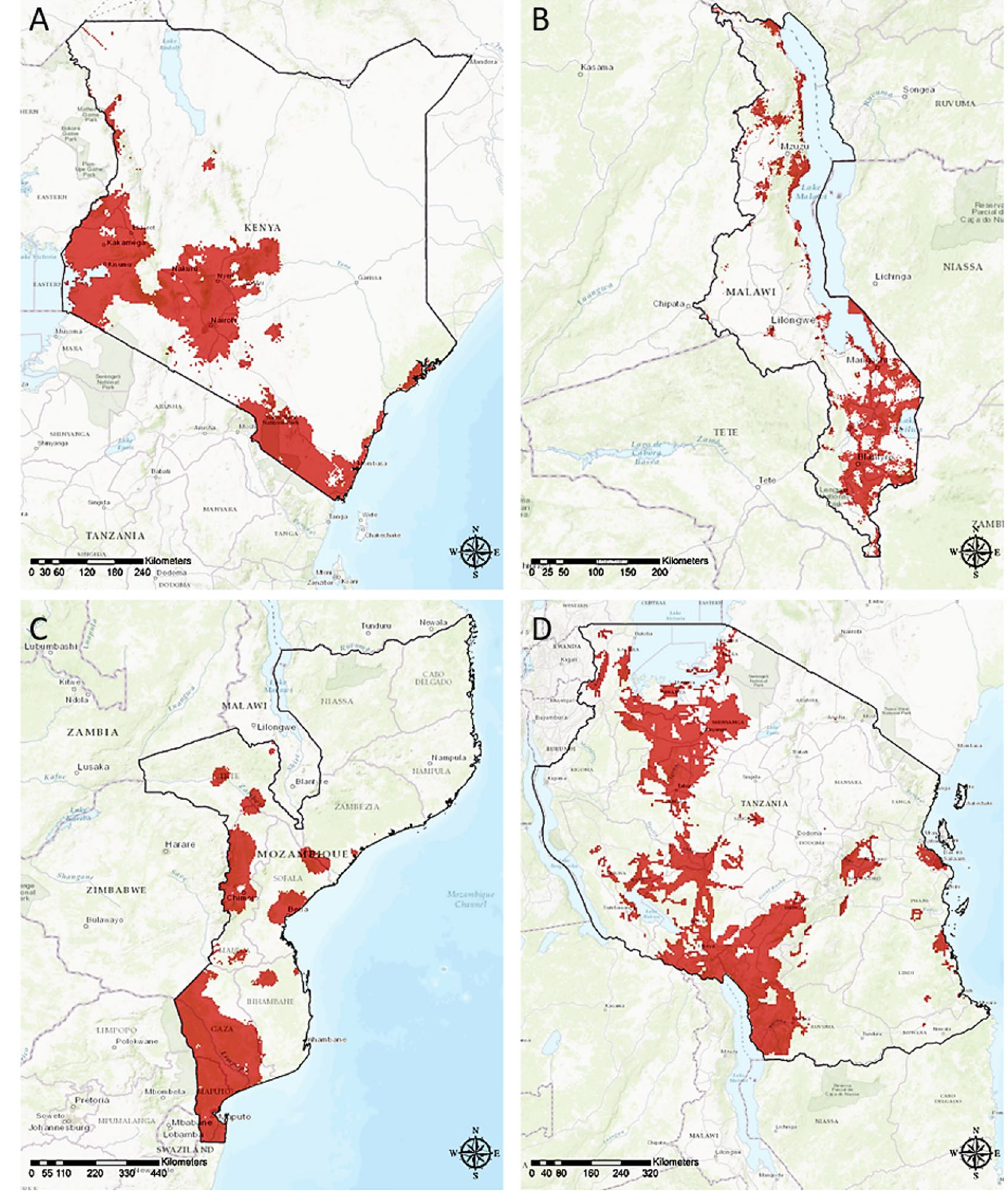
Figure 3. Areas with high HIV prevalence ( ≥ 80 th percentile) in ( A ) Kenya; ( B ) Malawi; ( C ) Mozambique; and ( D ) Tanzania. Maps were created using ArcGIS ® software by Esri version 10.3 42 (http://www.esri.com/).